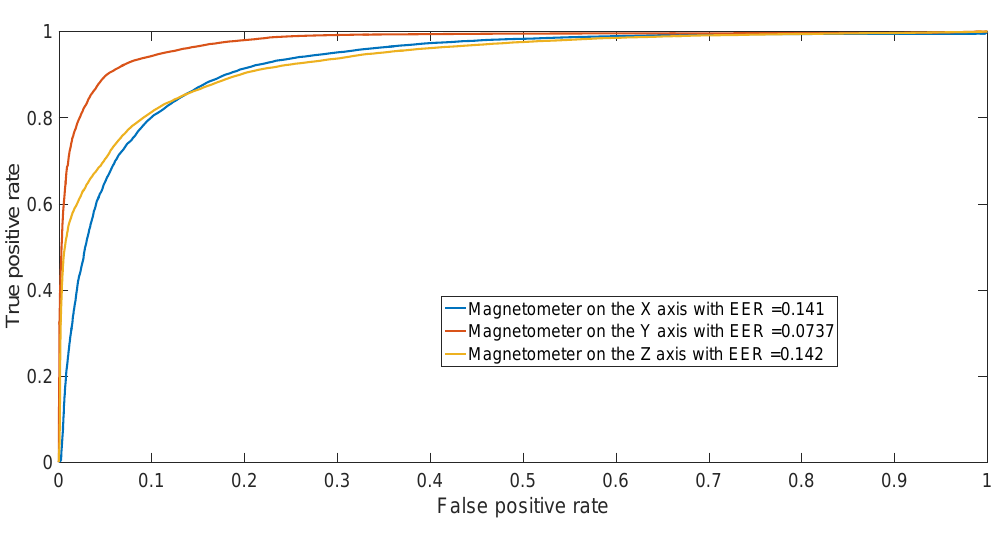
Figure 9. ROC achieved by SVM in binary classification between Sony Experia X and Samsung Galaxy S7. Results have been averaged over the 50 repetitions.